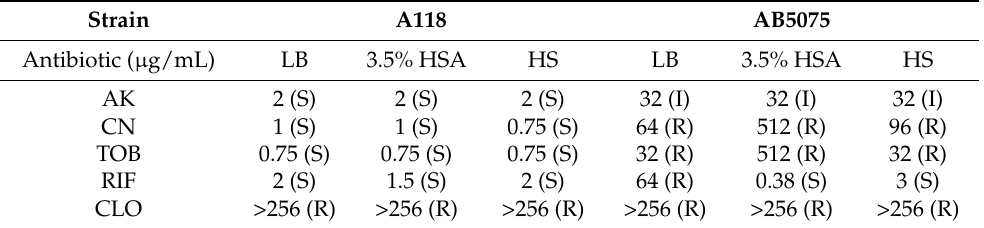
Table 1. MICs of A118 or AB5075 grew in LB, LB plus 3.5 % HSA, or HS.